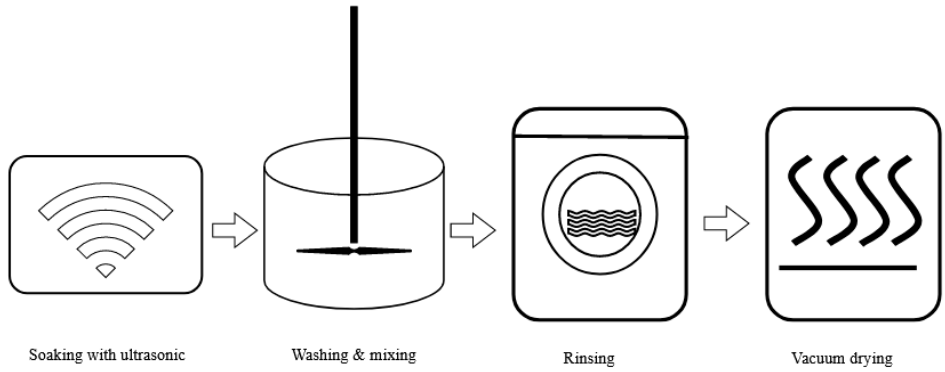
Figure 3. The cleaning process.